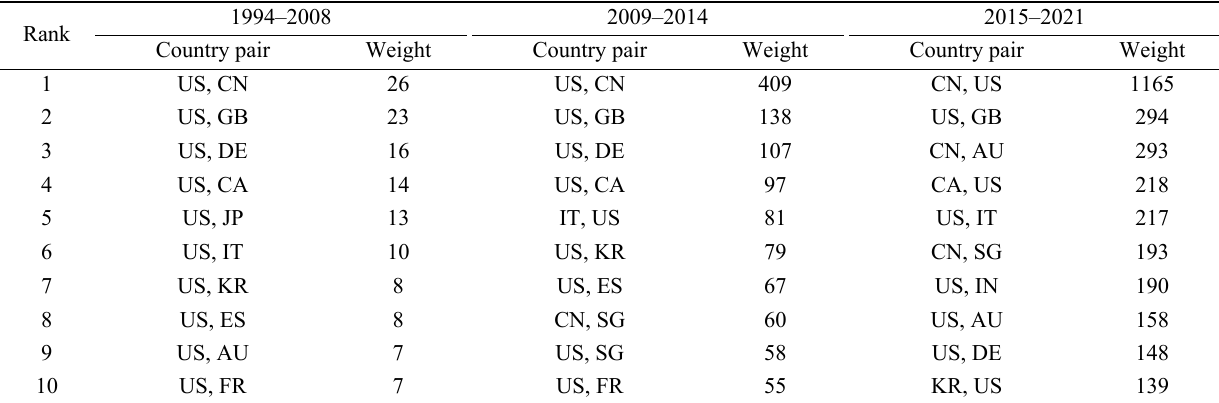
Table 7 Core countries and effective sizes in the country collaboration network in different time stages.